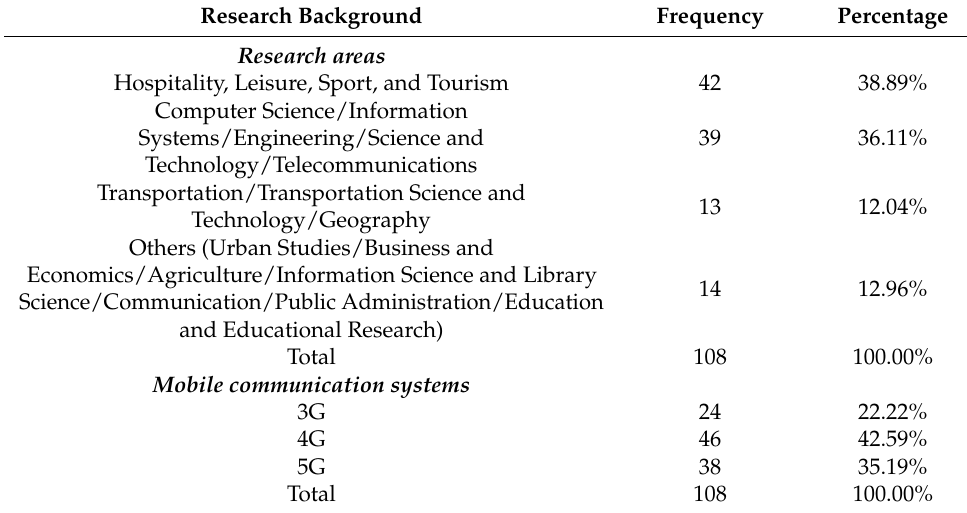
Table 1. Research background of mobile communication technology in hospitality and